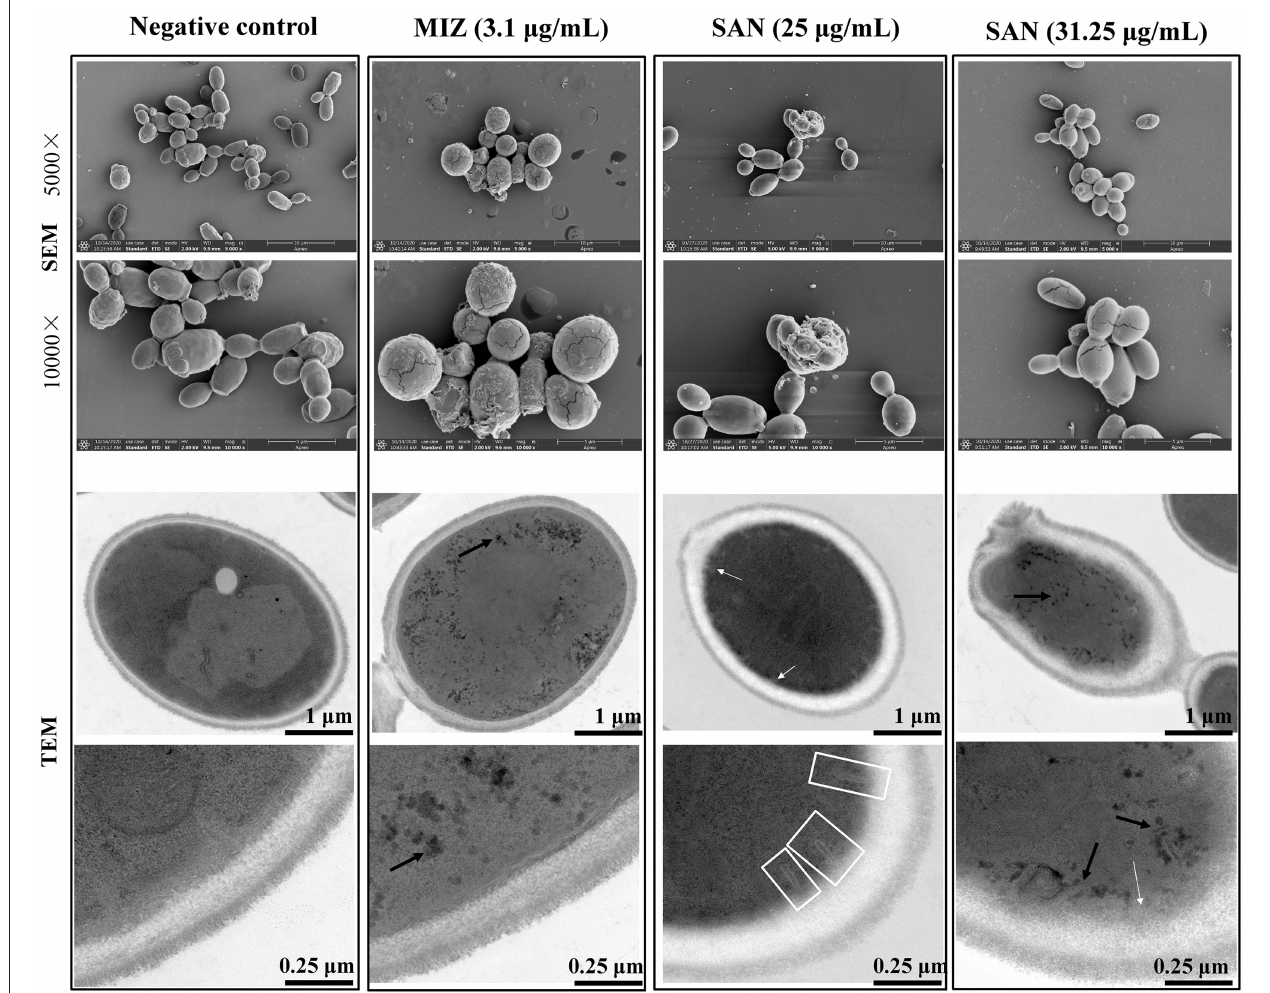
FIGURE 2 | SEM and TEM visualization of the cross sections of the untreated miconazole and SAN-treated C. albicans (ATCC 10231) cells after 24h. Cells were observed under SEM at 5000 × and 10000 × magnification. TEM showed the changes in cell ultrastructure after incubation with SAN or miconazole including the following: cell showing organelles leakage from vacuole (black arrows), multilayer structures (shown by white arrows) in the plasma membrane, and invaginations of the plasma membrane extending into the cytoplasm (shown by white frames). Three independent experiments, six biological replicates/group, were performed for each drug treatment. Micrographs in this image represent one of six biological replicates